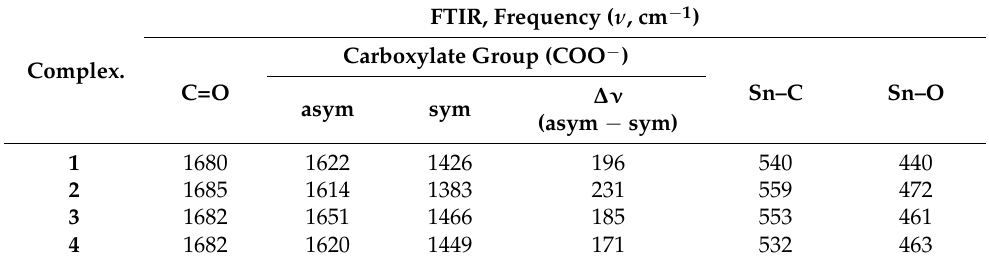
Table 2. The FTIR absorption bands of complexes 1–4 .